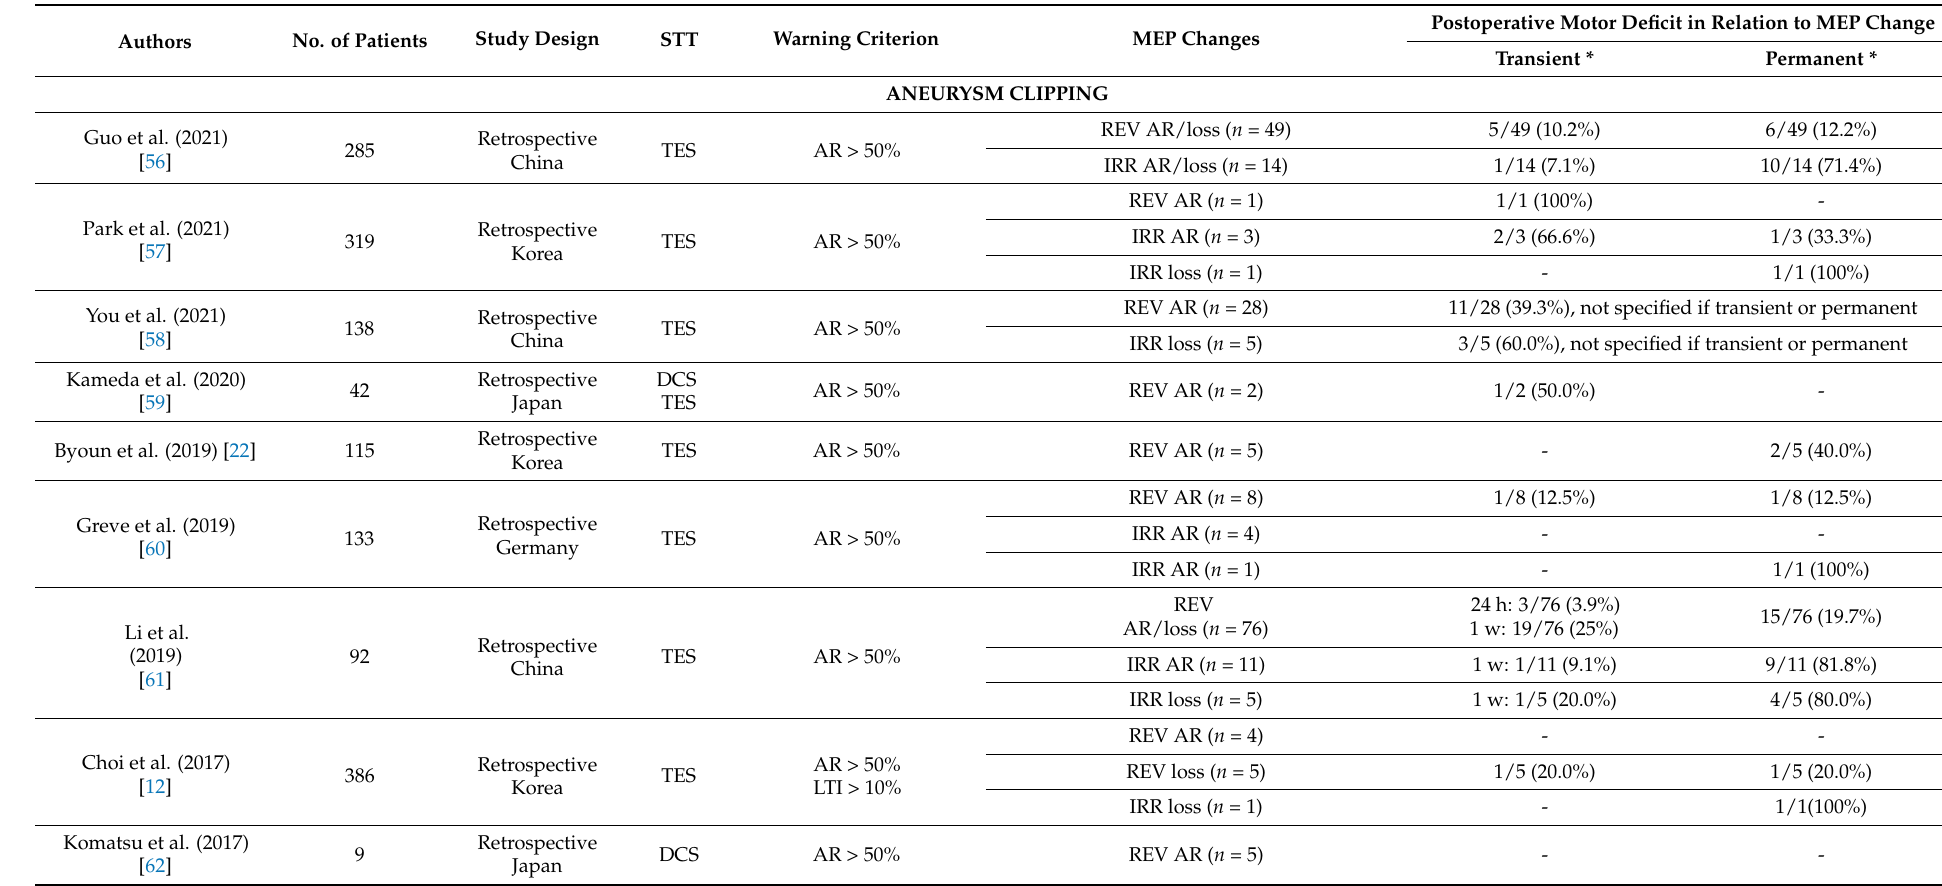
Table 2. Overview of included studies with aneurysm clipping and endovascular procedures for aneurysms. Number of included patients, study design, stimulation parameters, MEP warning criteria, number of patients who met these criteria as well as the relation with postoperative motor deficits are presented. Two case reports are also summarized in this table. *: The results are presented as the total number and percentage of patients with the indicated MEP warning criterion who developed a transient and permanent motor deficit. In studies with outcome reporting at distinct time-points, the results are presented as the total number and percentage of patients with the indicated MEP warning criterion who had a new postoperative motor deficit still present at the indicated time-point that resolved thereafter. £: 3/116 cases = not assessable. The absence of cases with a deficit is indicated by the symbol